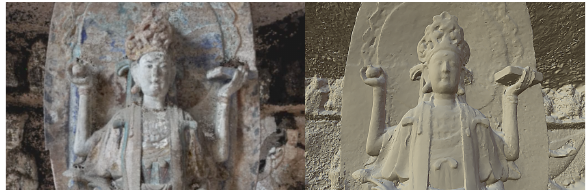
Figure 6: Point cloud view (L) and low-polygonal view of Peacock Radiant Wisdom King at Cave No.8 in Shemenshan, Dazu Rock